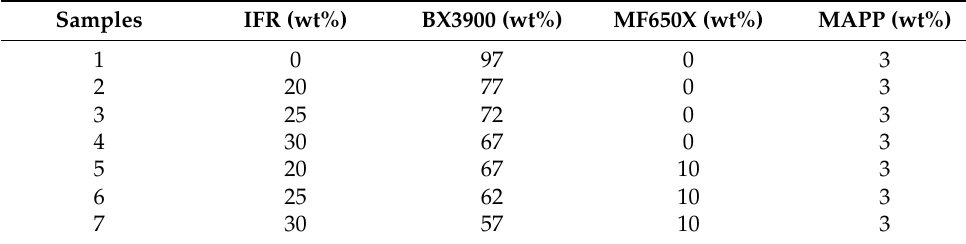
Table 1. Each group of flame-retardant modified